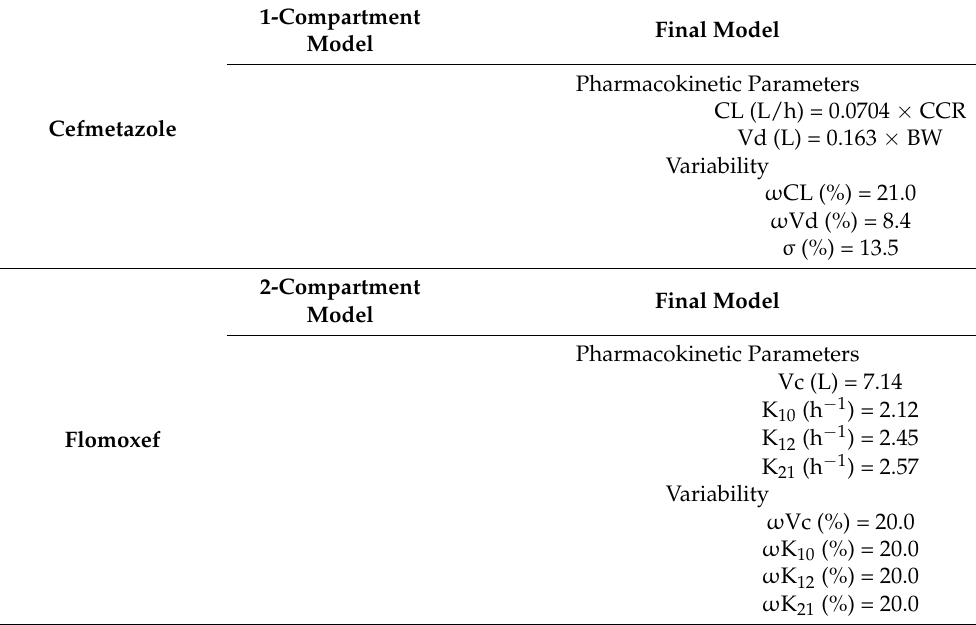
Table 1. Population pharmacokinetic models for Monte Carlo simulation [20,22].